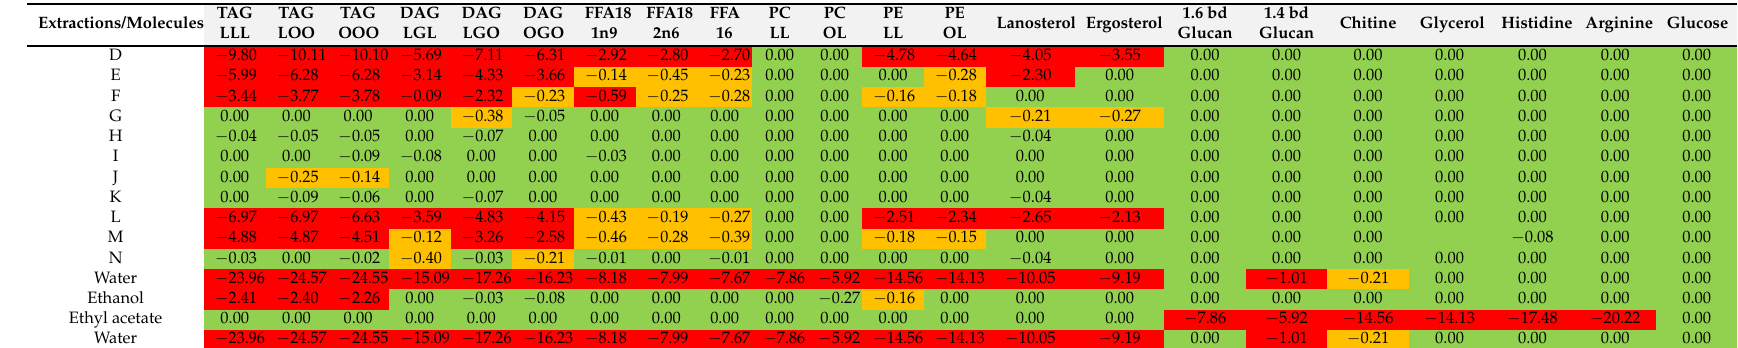
Table 4. Results given by COSMO-RS: simulation of modeled molecules in different systems of extractions realized in the experimental part. Green (0),